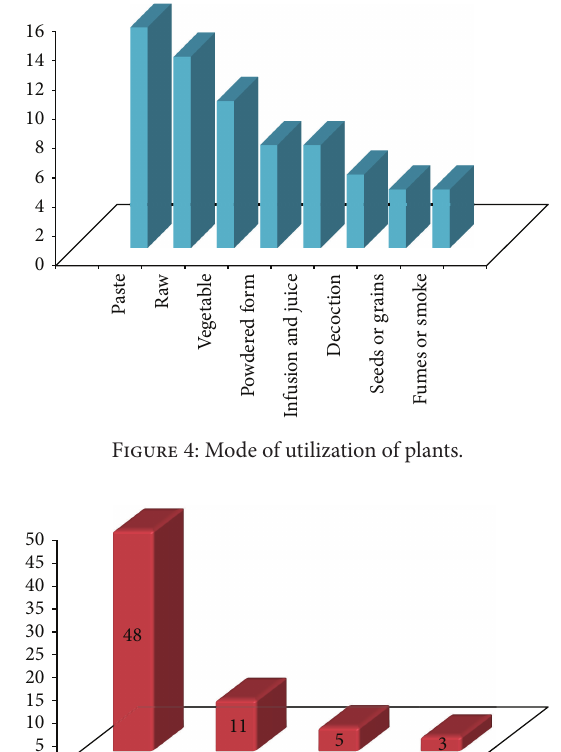
Figure 5: Life form of reported common